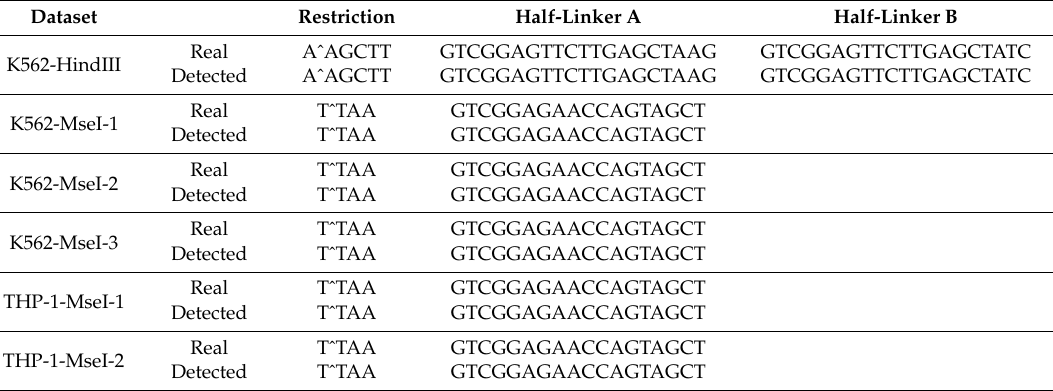
Table 2. Digestion-ligation-only (DLO) Hi-C tool performance on enzyme and linker